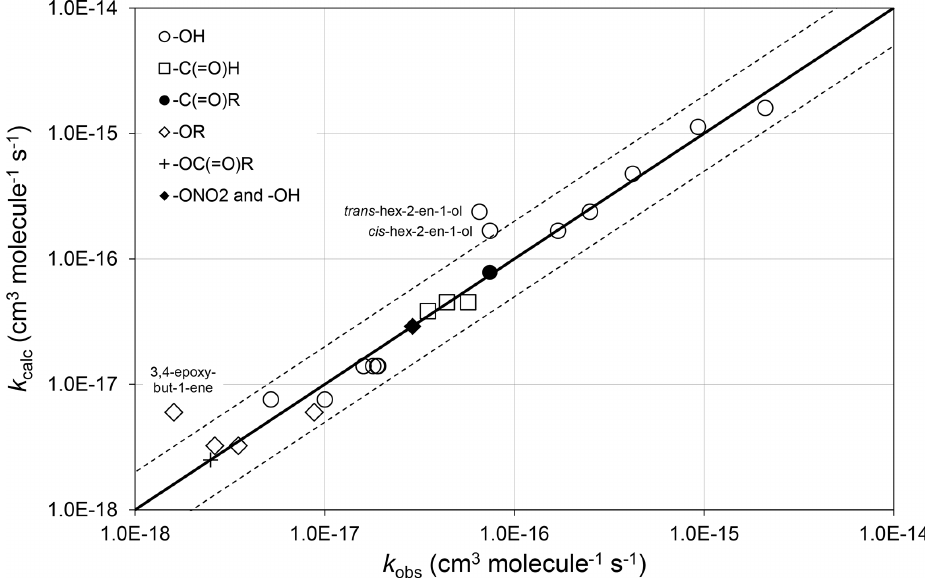
Figure 3. Scatter plot of observed and calculated values of k at 298K for the reactions of O 3 with allylic oxygenated compounds possessing the groups shown (see Sect. 4.1). The broken lines show the factor-of-2 range.